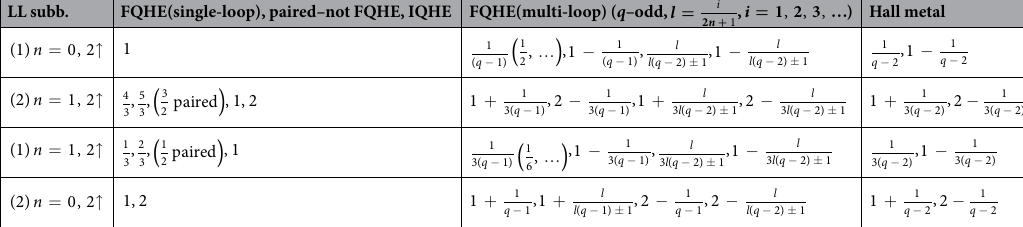
Table 2. Comparison of filling hierarchies in the LLL level in bilayer graphene for two mutually inverted successions of the two lowest subbands: = ↑ n 0, 2 , = ↑ n 1, 2, (upper – first two rows) and = ↑ n 1, 2 , = ↑ n 0, 2 (lower – last two rows). FQHE at ν = 1 exists for the upper sequence of subbands and it disappears for the 2 lower subband sequence.